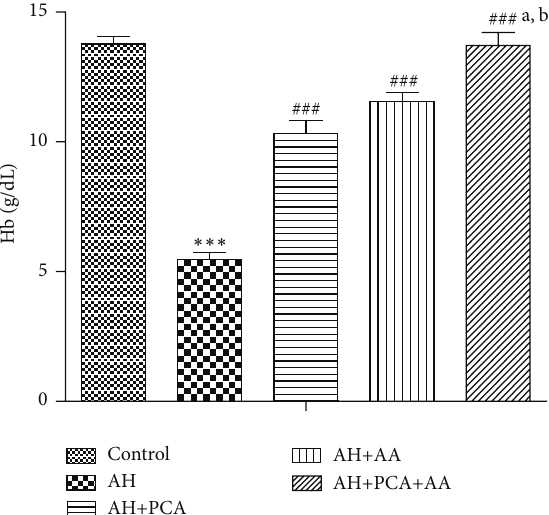
Figure 1: Effect of PCA alone and in combination with AA on RBCs and WBCs in AH-treated rats. Values are expressed as mean ± SEM. Level of significance is considered as ∗ 𝑝 < 0.05 , ∗∗ 𝑝 < 0.01 , and ∗∗∗ 𝑝 < 0.001 compared to control group. # 𝑝 < 0.05 , ## 𝑝 < 0.01 , and ### 𝑝 < 0.001 compared to AH-treated group. a 𝑝 < 0.05 compared to AH+PCA and b 𝑝 < 0.05 compared to AH+AA group.